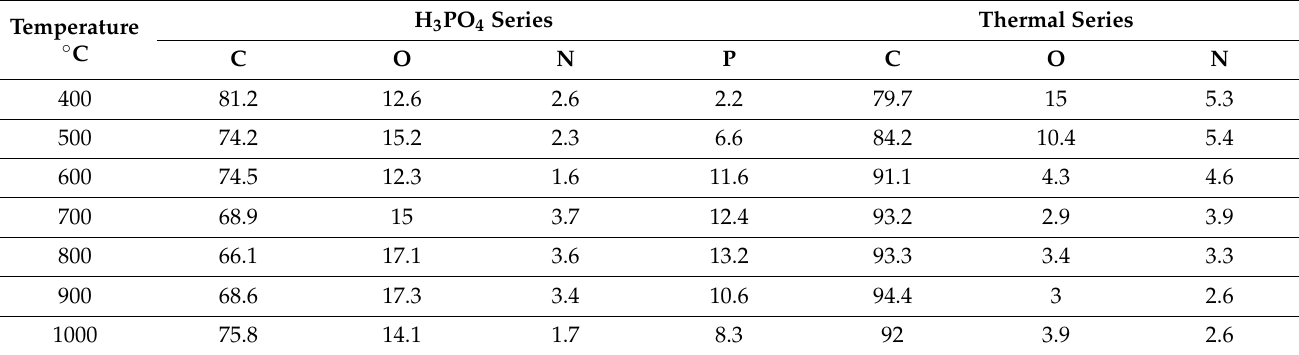
Table 2. Chemical composition (in mass%) of polyimide-derived carbons. Temperature ◦